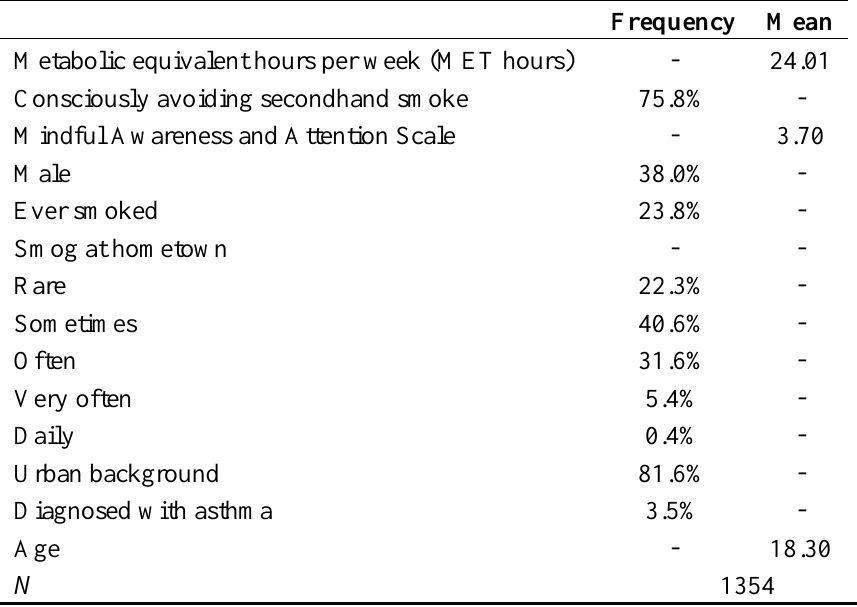
Table 1. Descriptive statistics of the sample from Shanghai University of Finance and Economics.